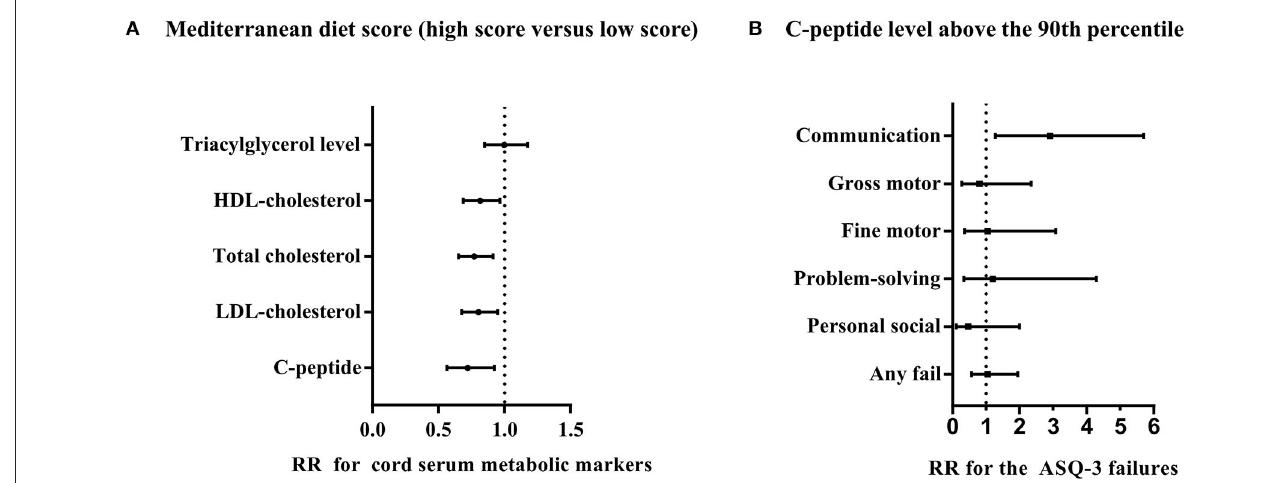
FIGURE1 Associations of Mediterranean diet score with cord blood markers and associations of cord blood markers with ASQ-3 failures. (A) RRs with 95% CI for the dichotomous outcomes of cord blood level are for Mediterranean diet score (4–7 vs. 0–3). (B) RRs with 95% CI for the dichotomous outcomes of ASQ-3 failures including communication domain, gross motor domain, fine motor domain, problem-solving domain, personal social domain, and any failure for the cord C-peptide level above the 90th percentile. Both (A, B) adjusted confounders including maternal age, education, household income, pre-pregnancy BMI, gestational diabetes, blood pressure (systolic and diastolic), anemia during pregnancy, depressive symptoms, pregnancy history, maternal physical exercise, and the supplement of nutrients, such as vitamin D, folic acid, and iron, and (B) additionally adjusted delivery mode, gender, gestational week, and birth weight, and the patterns of infant feeding.